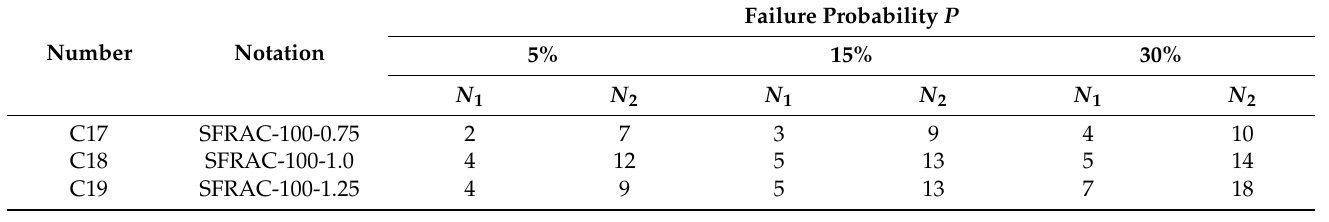
Table 6. Impact blows of FRAC for different probabilities of failure.